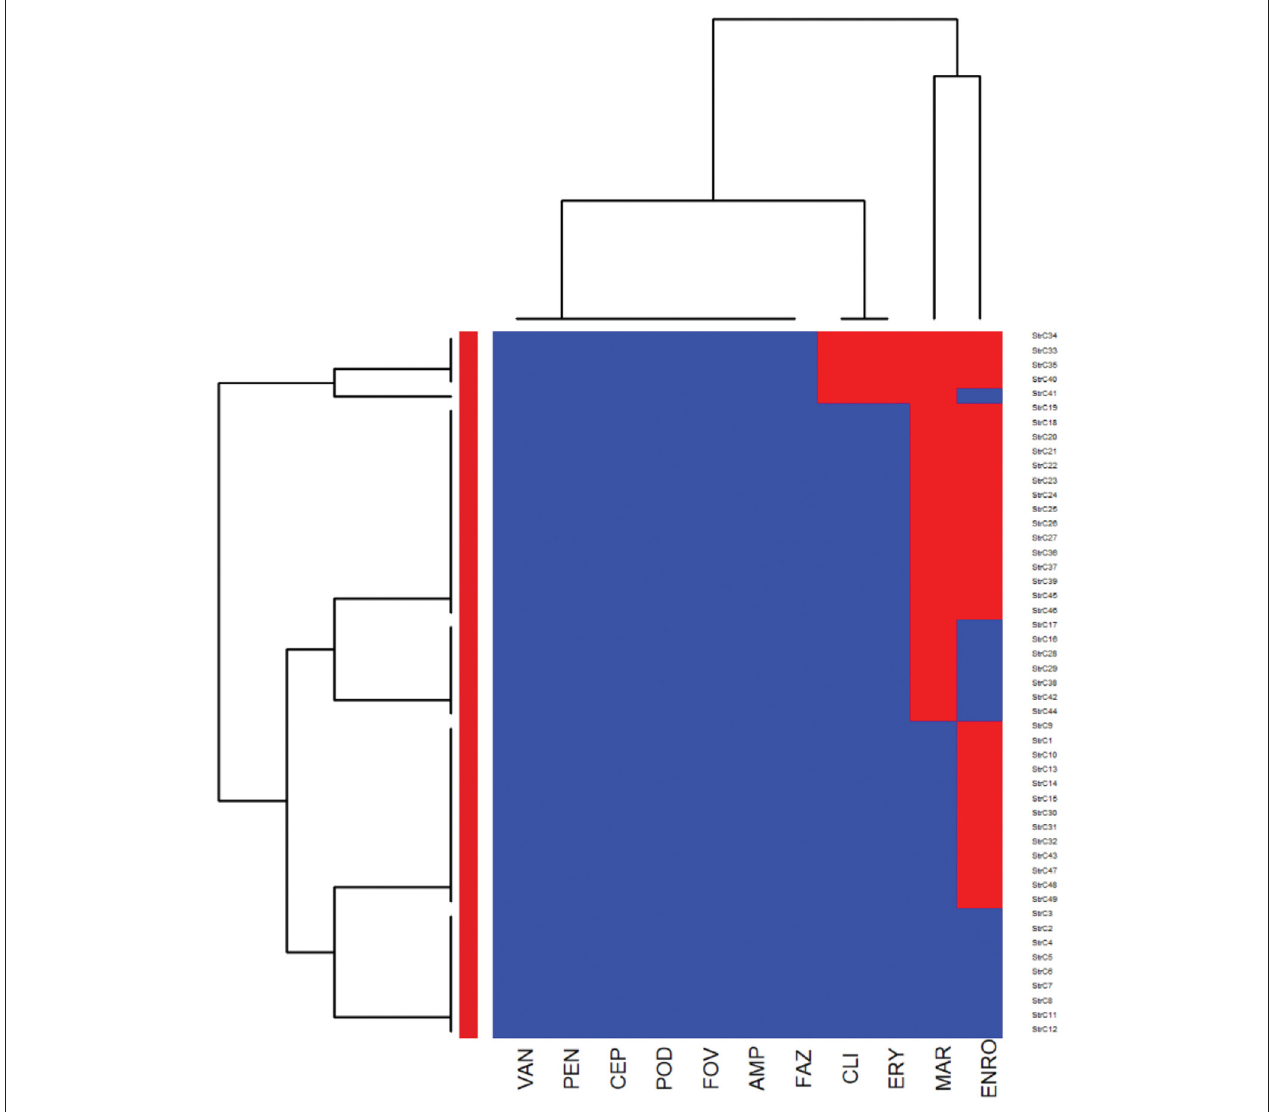
FIGURE 2 | Hierarchical clustering dendrogram of antimicrobial resistance patterns in Streptococcus canis isolated from canine urine samples a,b,c . a FAZ, Cefazolin; FOV, cefovecin; POD, cefpodoxime; CEP, cephalothin; ERY, erythromycin; ENRO, enrofloxacin; MAR, marbofloxacin; VAN, vancomycin; CLI, clindamycin; AMP, ampicillin; PEN, penicillin. b Heatmap generated by hierarchical clustering of the antimicrobial resistance determinants (columns) of bacterial isolates (rows). c Red color, resistant; blue color, susceptible.